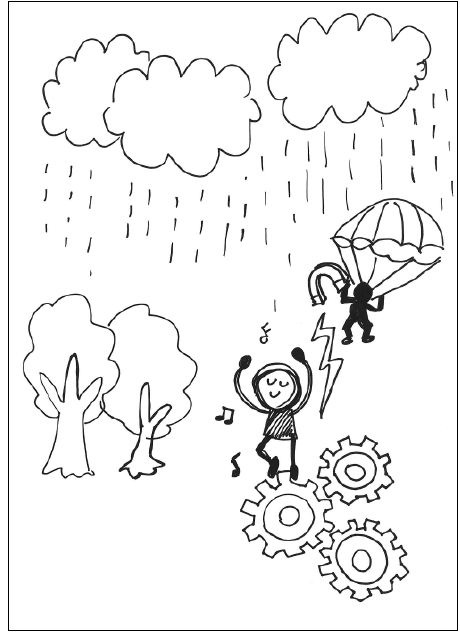
Figure 3. Work by PT3 Conscientiousness.